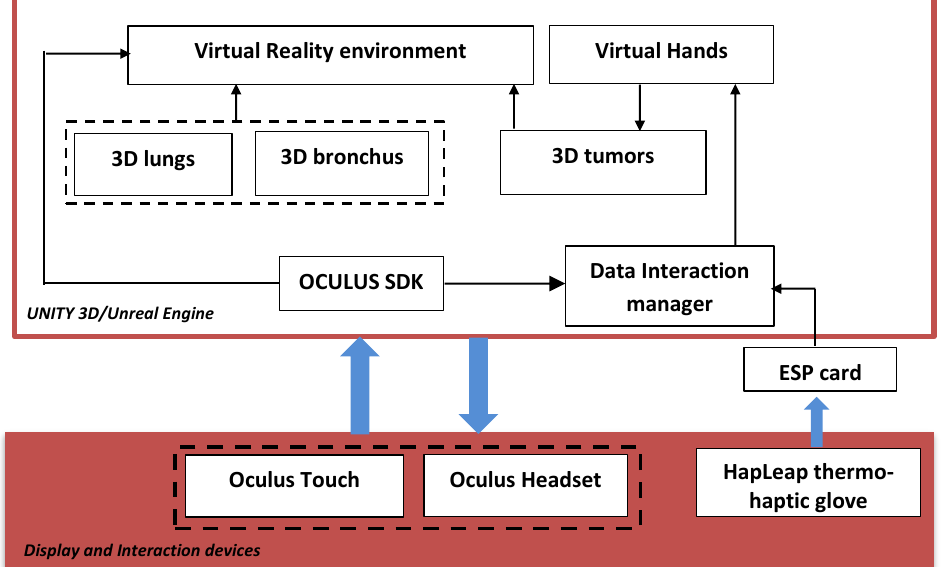
Figure 2. General diagram of the proposed